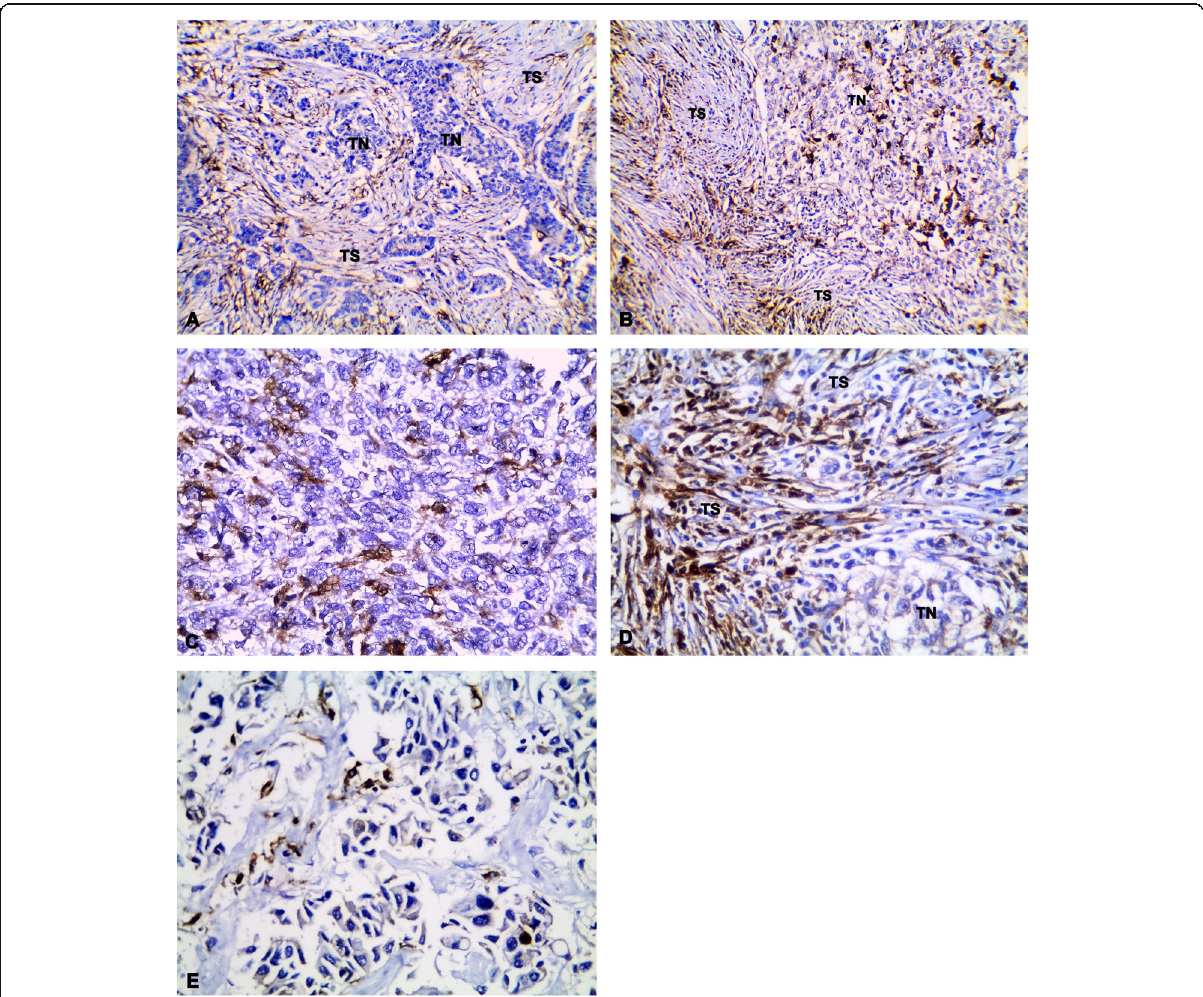
Fig. 2 CD163-positive tumor-associated macrophages (TAMs). a CD163-positive TAMs mainly in tumor stroma (TS) with few within tumor nest (TN) in GII case (× 200). b CD163-positive TAMs within both tumor nest and stroma in GIII case (× 200). c High density of CD163-positive TAMs infiltrating tumor nest in GIII case (× 400). d High density of CD163-positive TAMs within tumor stroma in GIII tumor (× 400). e Low density of CD163-positive TAMs in both tumor nest and stroma in GII case (×